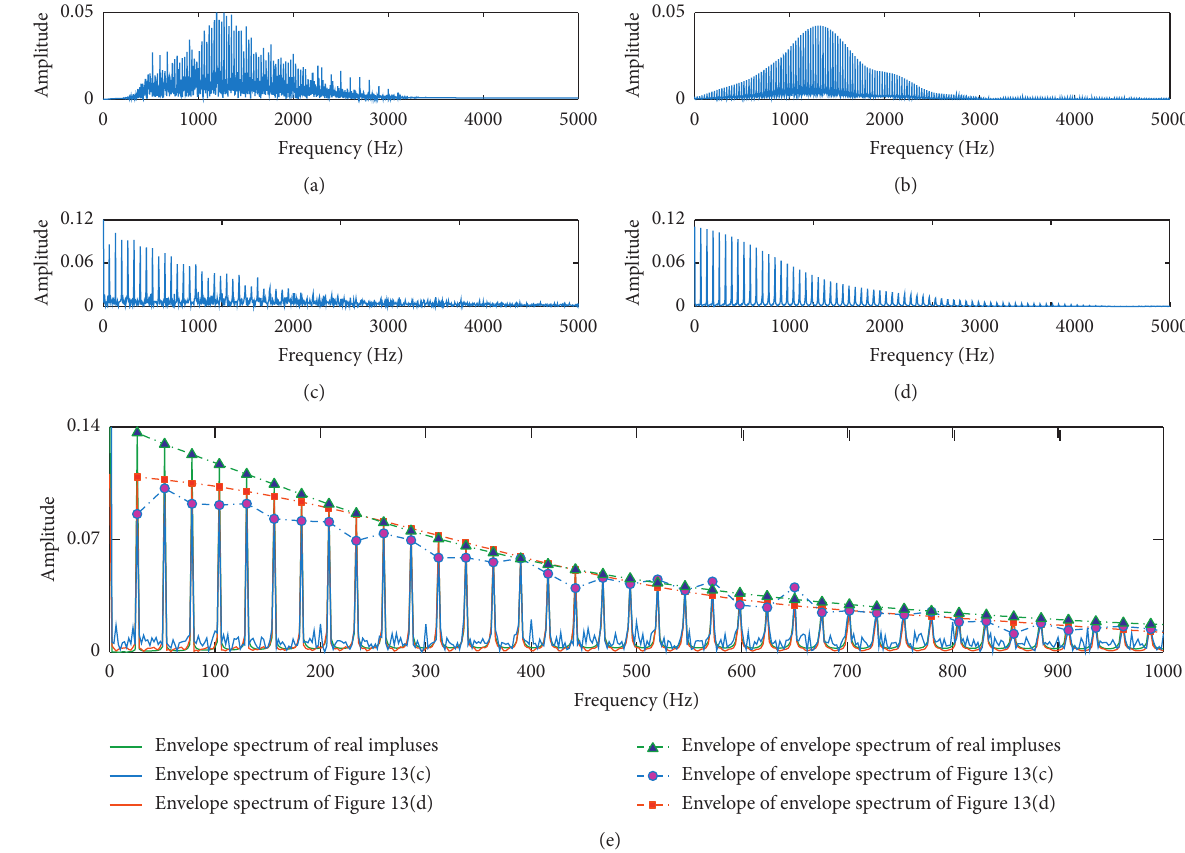
Figure 14: (a) Fourier spectrum of signal in Figure 13(c); (b) Fourier spectrum of signal in Figure 13(d); (c) and (d) envelope spectrums of signals in Figure 13(c) and in Figure 13(d), respectively; and (e) comparison between envelope spectrum of real impulses and obtained envelope spectrum (envelope spectrums in Figures 14(c) and